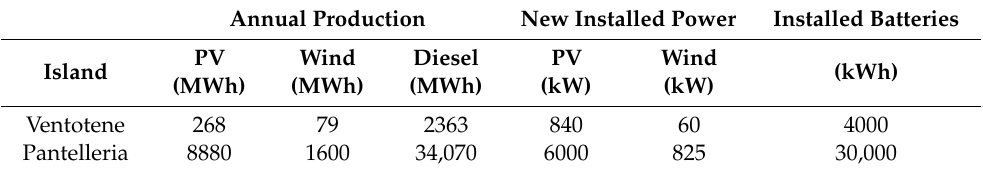
Table 4. Energy mix of the islands in the advanced energy scenario (also named “second scenario”). Annual Production New Installed Power Installed Batteries